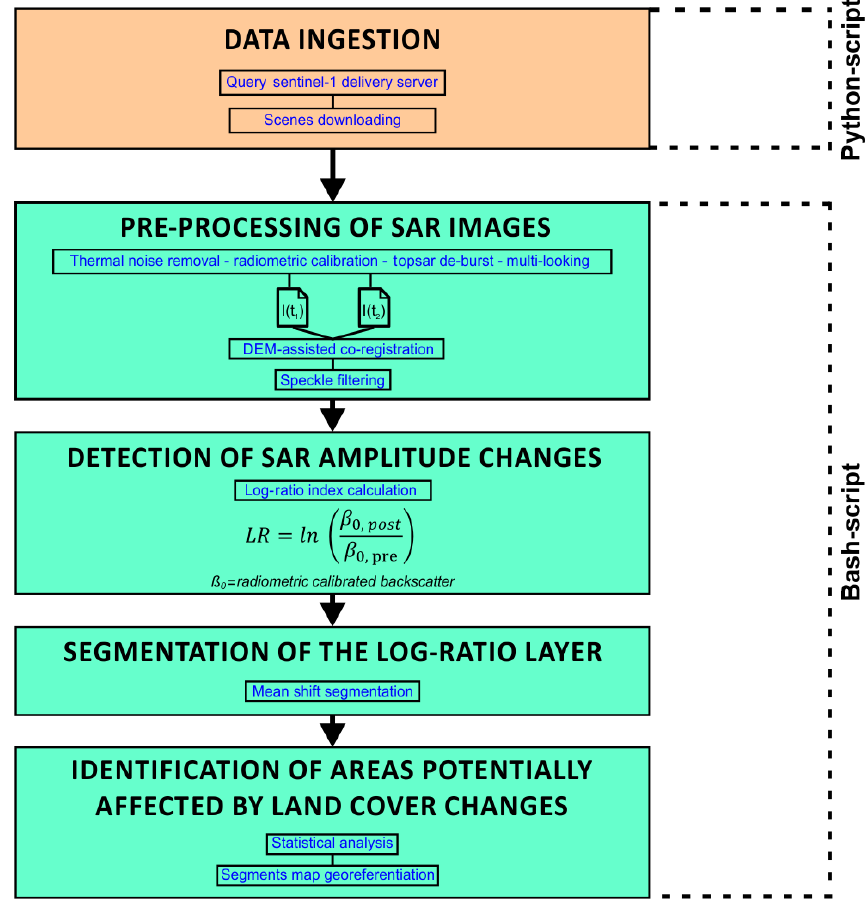
Figure 1. Flowchart representing the automatic steps of the processing chain implemented in two groups of scripts (developed using Python and Bash scripting languages). I(t 1 ) and I(t 2 ) represent two consecutive SAR images (or set of